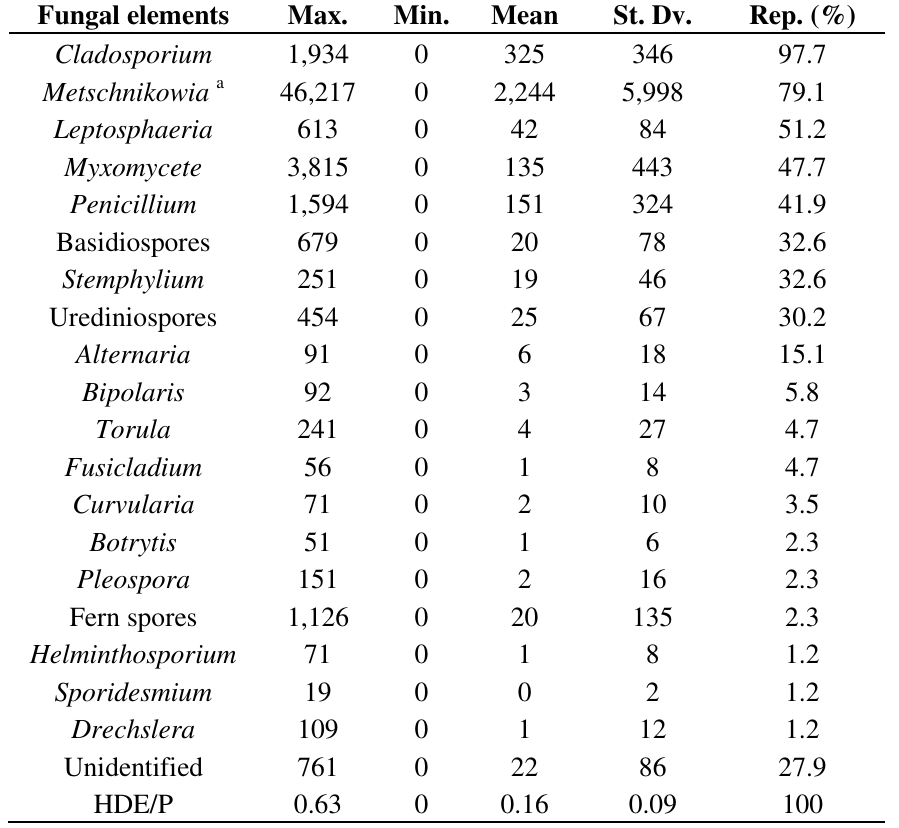
Table 2. Descriptive analysis of microscopic elements per g of honey. Fungal